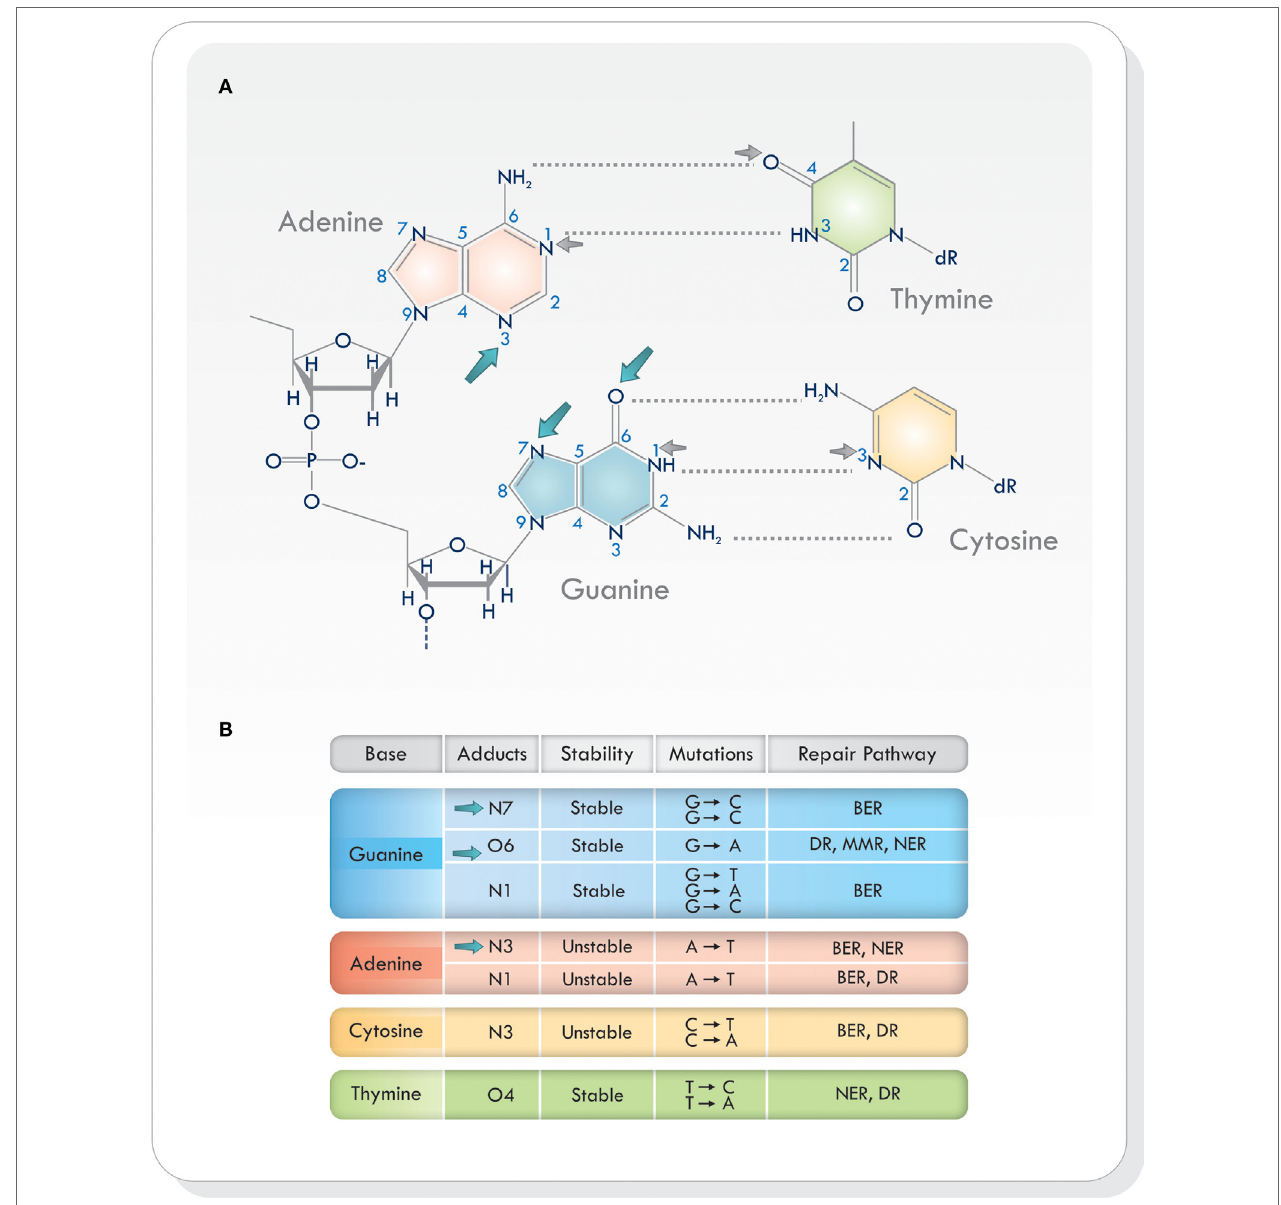
FiGURe 1 | (A) Sites of alkylation on the various bases in the DNA. Temozolomide produces alkylation on position N7 and O6 in guanine and N3 in adenine (blue arrows). Other alkylating agents act on different sites of alkylation (small gray arrows). (B) Chemical stability, mutagenesis, cytotoxicity, and repair mechanisms in different sites of alkylation. Based on Ref. (8, 9, 16, 19). Abbreviations: BER, base excision repair; DR, direct repair; MMR, mismatch repair; NER, nucleotide excision repair; DNA, deoxyribonucleic